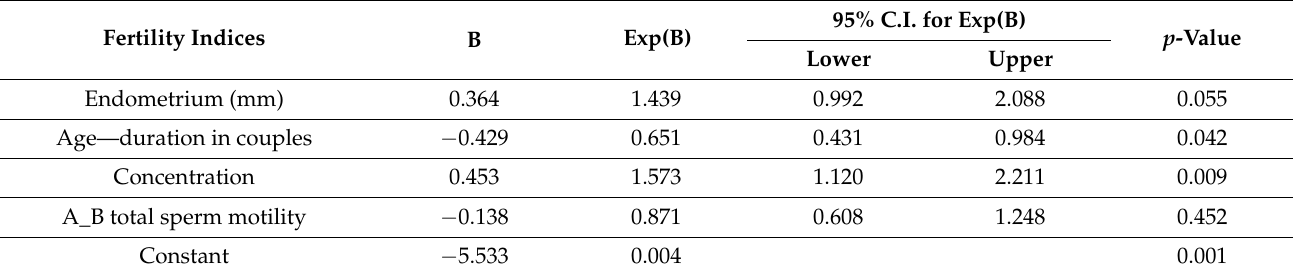
Table 3. Multiple logistic